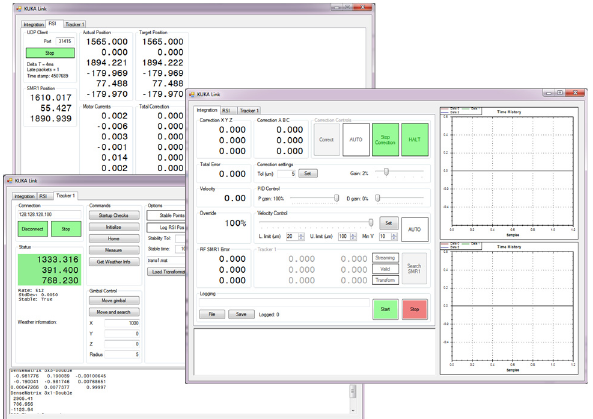
Figure 8. PC control software developed for real-time compensation.